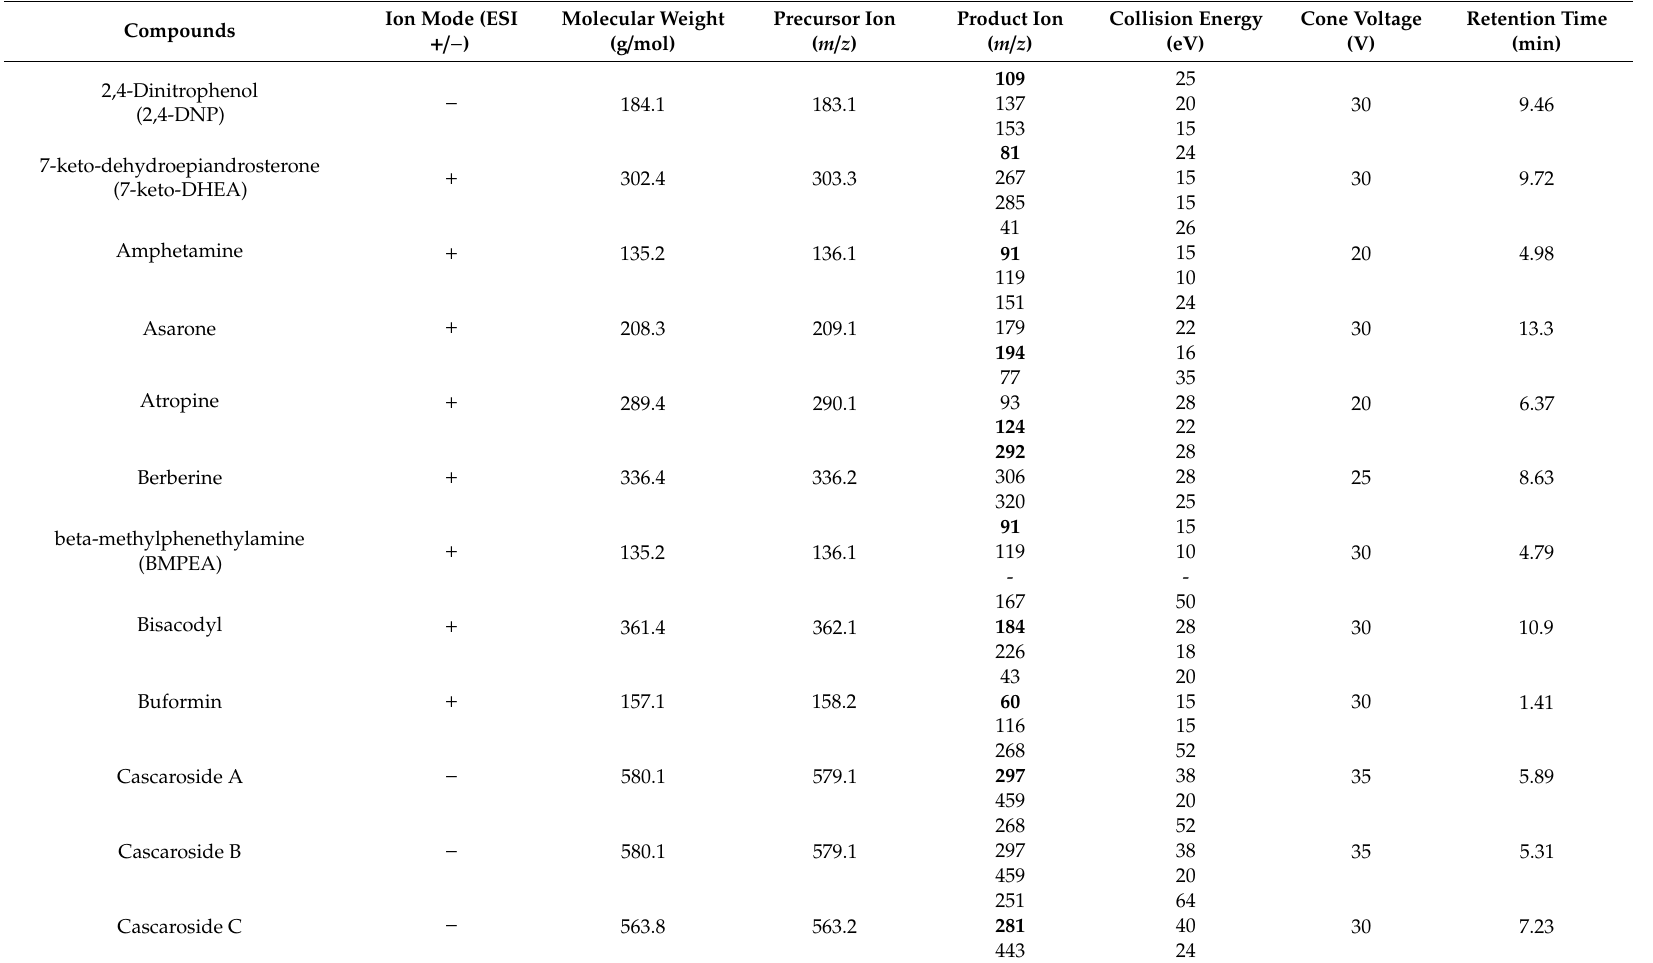
Table 1. MRM transition and optimized parameters of LC-MS / MS for 64 target